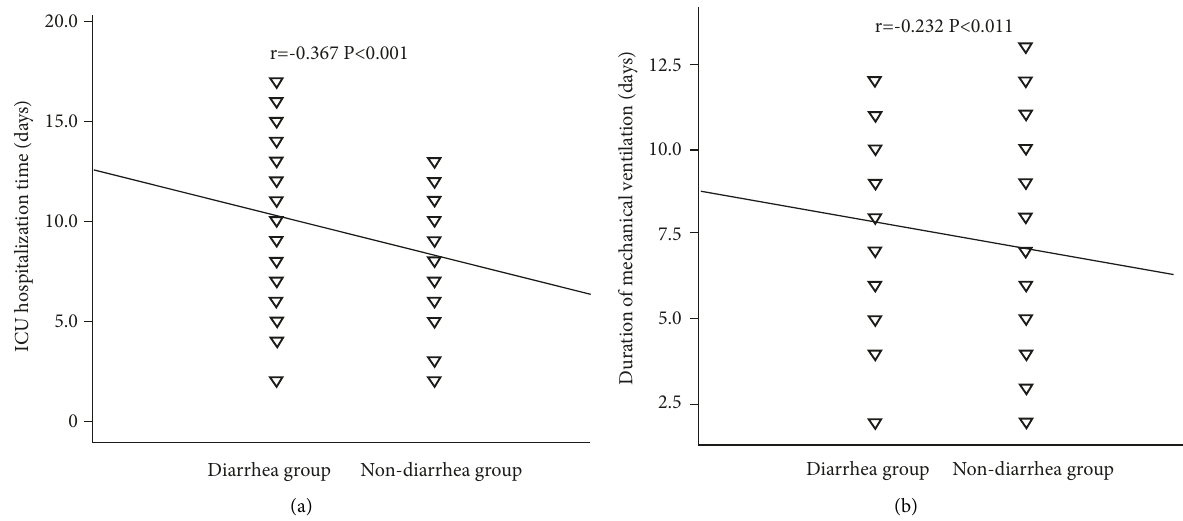
Figure 3: Correlation between ICU hospitalization time, mechanical ventilation time, and diarrhea risk. (a) The correlation between ICU